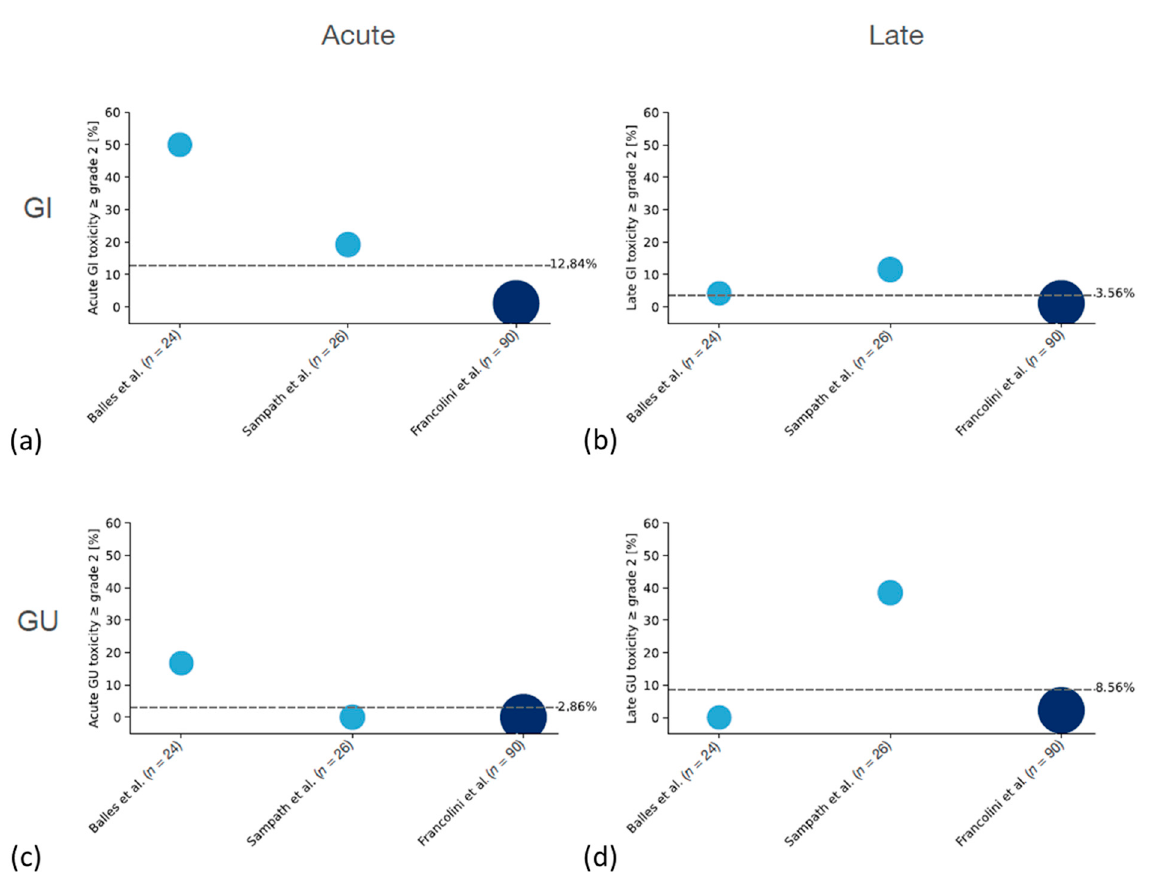
Figure 2. ( a – d ) Summary of ≥ G2 acute and late toxicities in patients without prior radiotherapy. Area and color of the dots indicate the size of the respective